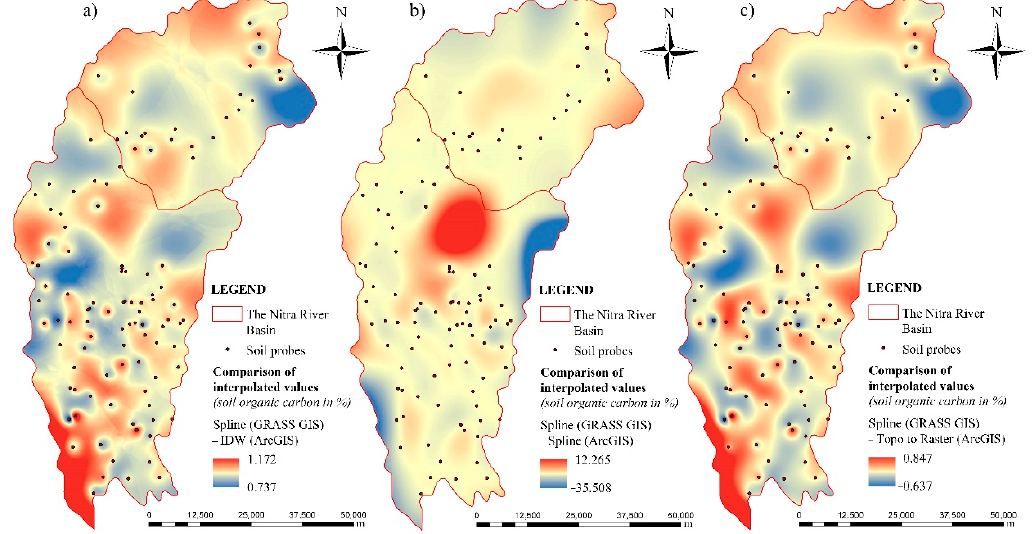
Figure 6. Comparison of GRASS GIS Spline with other interpolation methods for CO x content: ( a ) Spline (GRASS GIS)—IDW (ArcGIS); ( b ) Spline (GRASS GIS)—Spline (ArcGIS); ( c ) Spline (GRASS GIS)—Topo to Raster (ArcGIS).